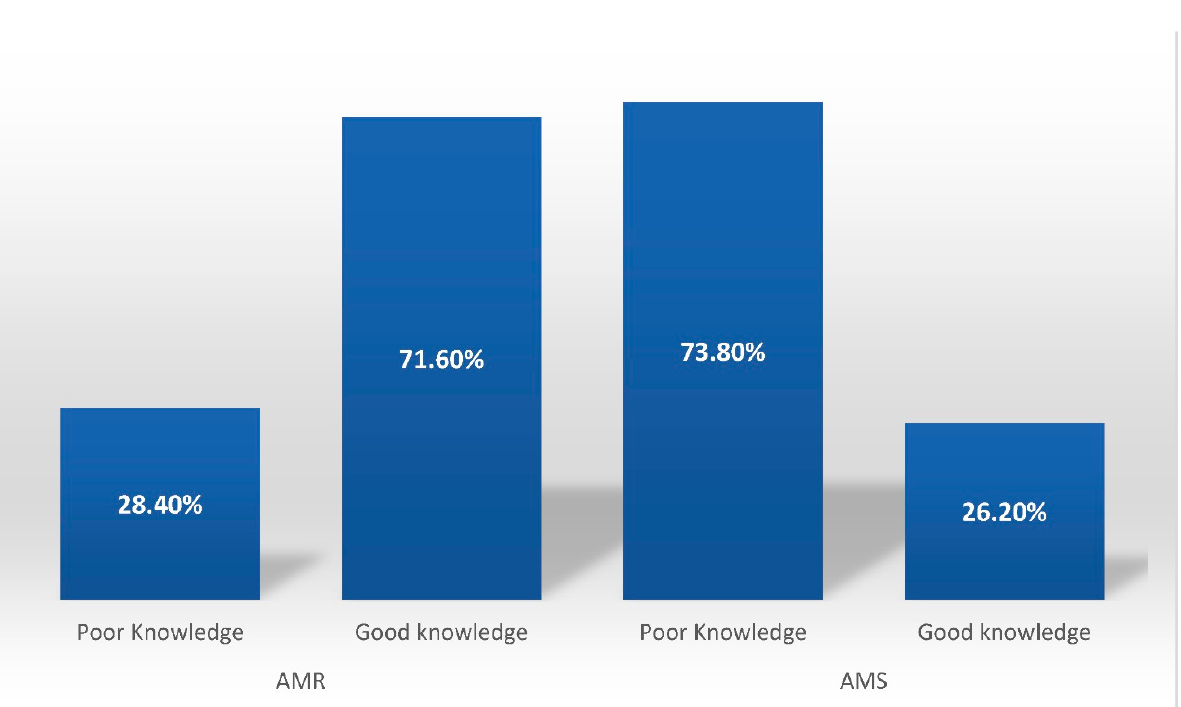
Figure 1. The knowledge of the study participants regarding antimicrobial resistance (AMR) and antimicrobial stewardship (AMS).